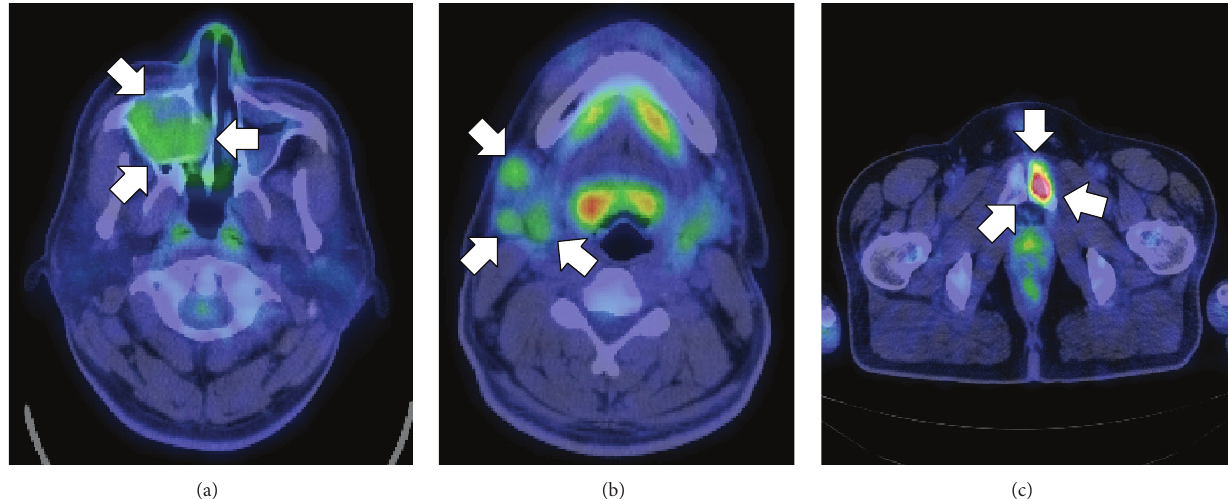
Figure 6: Strong SUVs are found in the right maxillary sinus ((a), arrows), right submandibular region ((b), arrows), and left pubic bone ((c), arrows) on an 18 F-FDG PET/CT